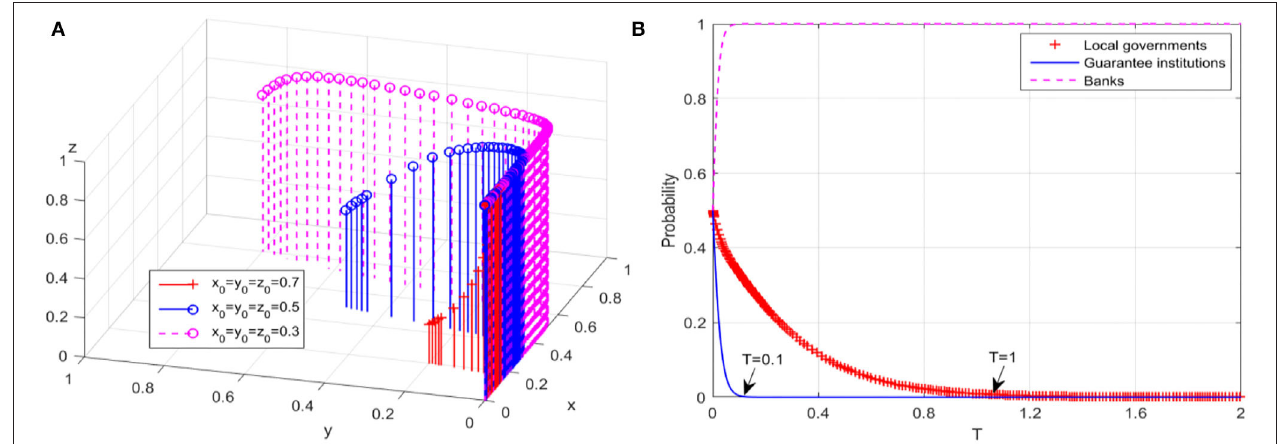
FIGURE 1 | Evolutionary results of low-level equilibrium. (A) Game system of guarantee market. (B) Behaviors of game players.